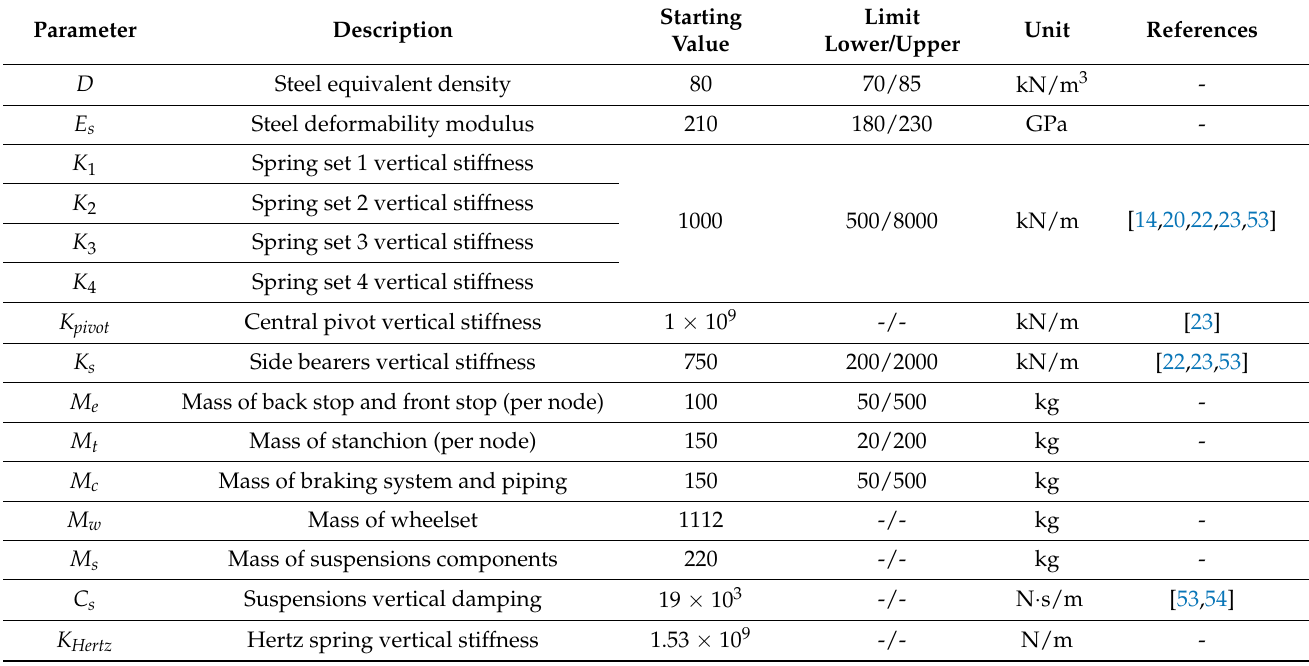
Table 2. Main parameters of the numerical model of Sgnss